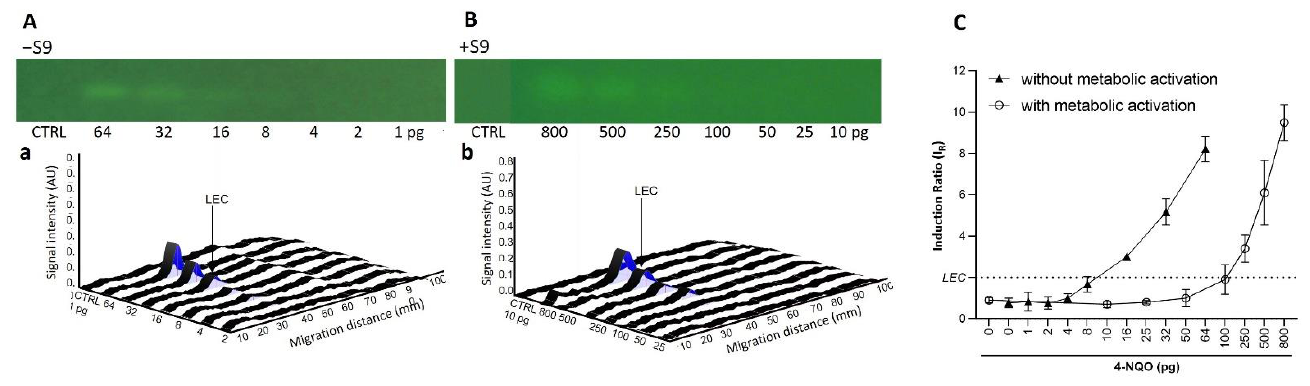
Figure 3. Dose–response effect for 4-NQO. Bioautograms at FLD 254 nm (region of interest shown) in absence ( − S9) ( A ) or presence (+S9) ( B ) of metabolic activation, with respective biodensitograms at 485/>500 nm (a and b). Dose–response curves with LEC (black dotted line at IR 2.0) ( C ). D-mannitol and melamine (100 − 800 ng/band) were selected as negative controls to demonstrate the specificity of the test. As expected, no genotoxic response was observed in the corresponding bioautograms and densitograms for both substances (Figure 4). The